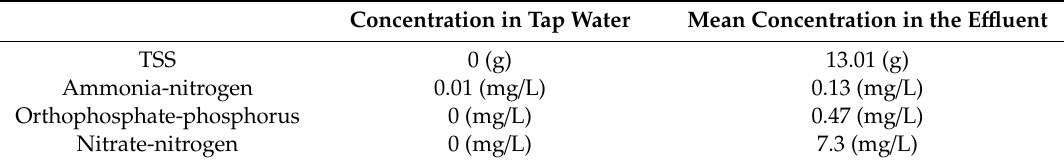
Table 4. Clean water test